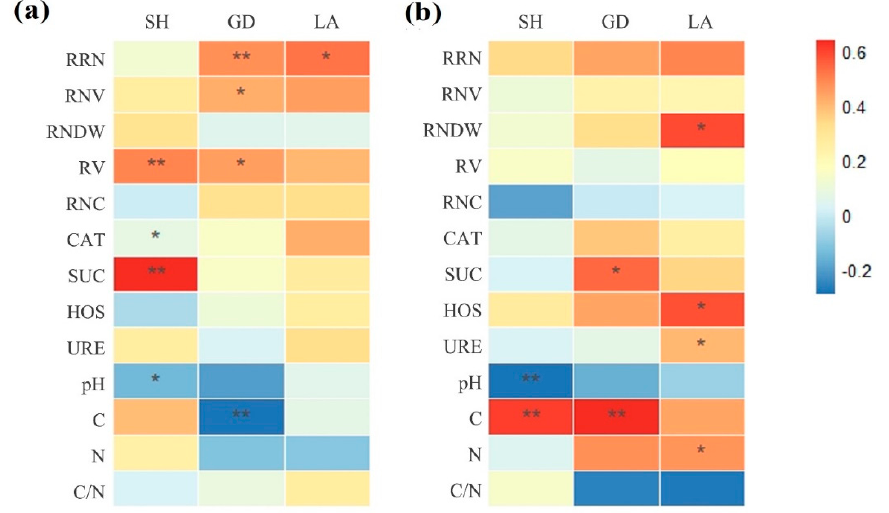
Figure 7. Pearson’s correlation analyzed differences between the growth conditions of R. pseudo-acacia ( a ) and L. bicolor ( b ). Significant correlations are marked in red (positive) and blue (nega-tive). ** indicates significant correlation at p < 0.01; * indicates significant correlation at p < 0.05. SH, height; GD, basal diameter; LA, leaf areas; RNN, root nodules number; RNV, root nodules volume; RNDW, root nodules dry weight; RV, root volume; RNC, root nodules contribution; CAT, soil catalase activity; SUC, soil sucrase activity; HOS, soil alkaline phosphatase activity; URE, soil urease activity; pH, soil pH; C, soil total carbon; N, soil total nitrogen; C/N, soil car-bon to nitrogen ratio. However, the height and basal diameter of L. bicolor primarily had positive